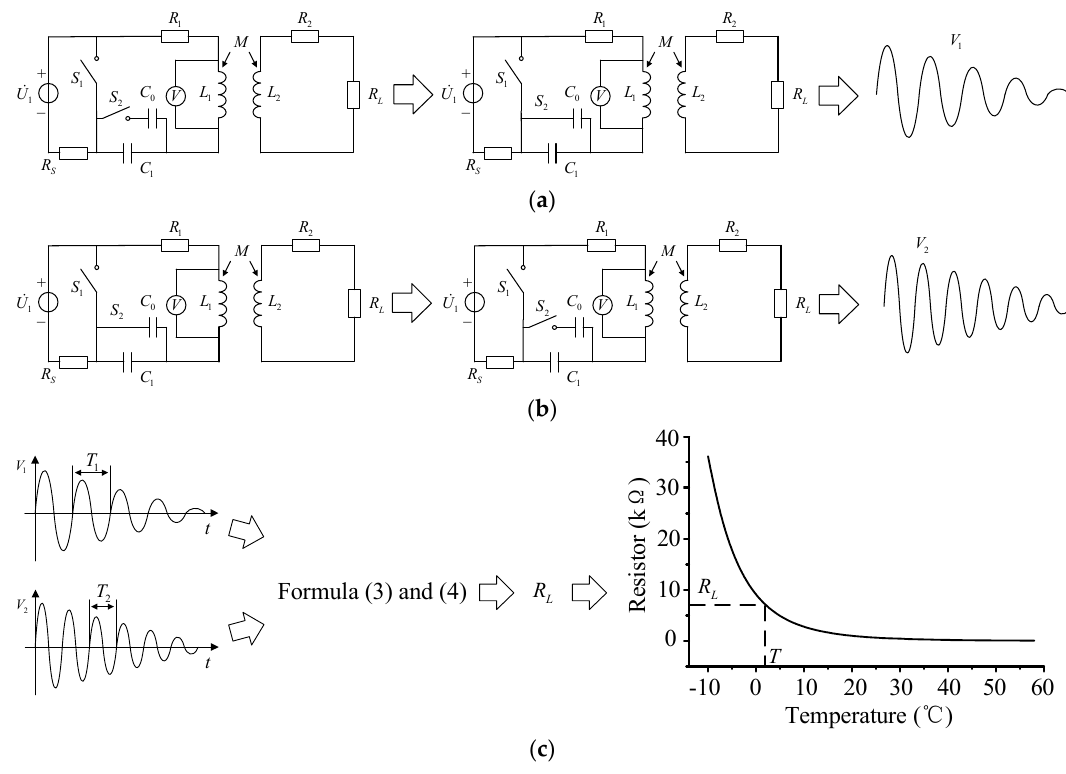
Figure 6. The measuring process of the passive wireless measurement system. ( a ) The first measurement, ( b ) the second measurement, ( c ) the calculation and comparison.